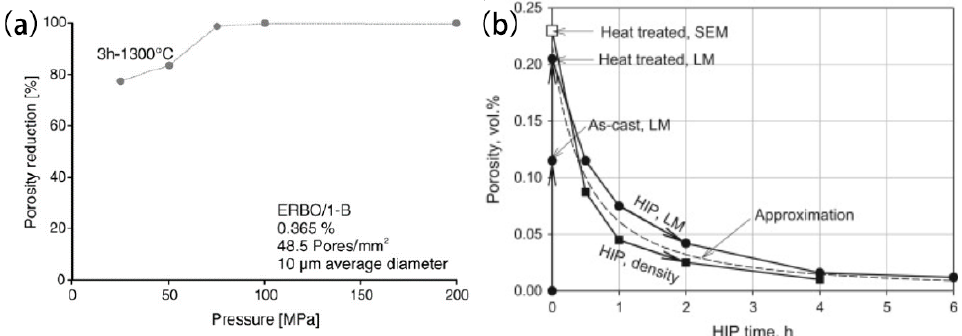
Figure 7. ( a ) Effect of the pressure on the annihilation of micropores of as- solutioning treated SX superalloy ERBO/1 [24] ; ( b ) Porosity in as-cast and heat treated SX superalloy CMSX-4 and its an- nihilation during HIP at 1288 °C/103 MPa [48] .